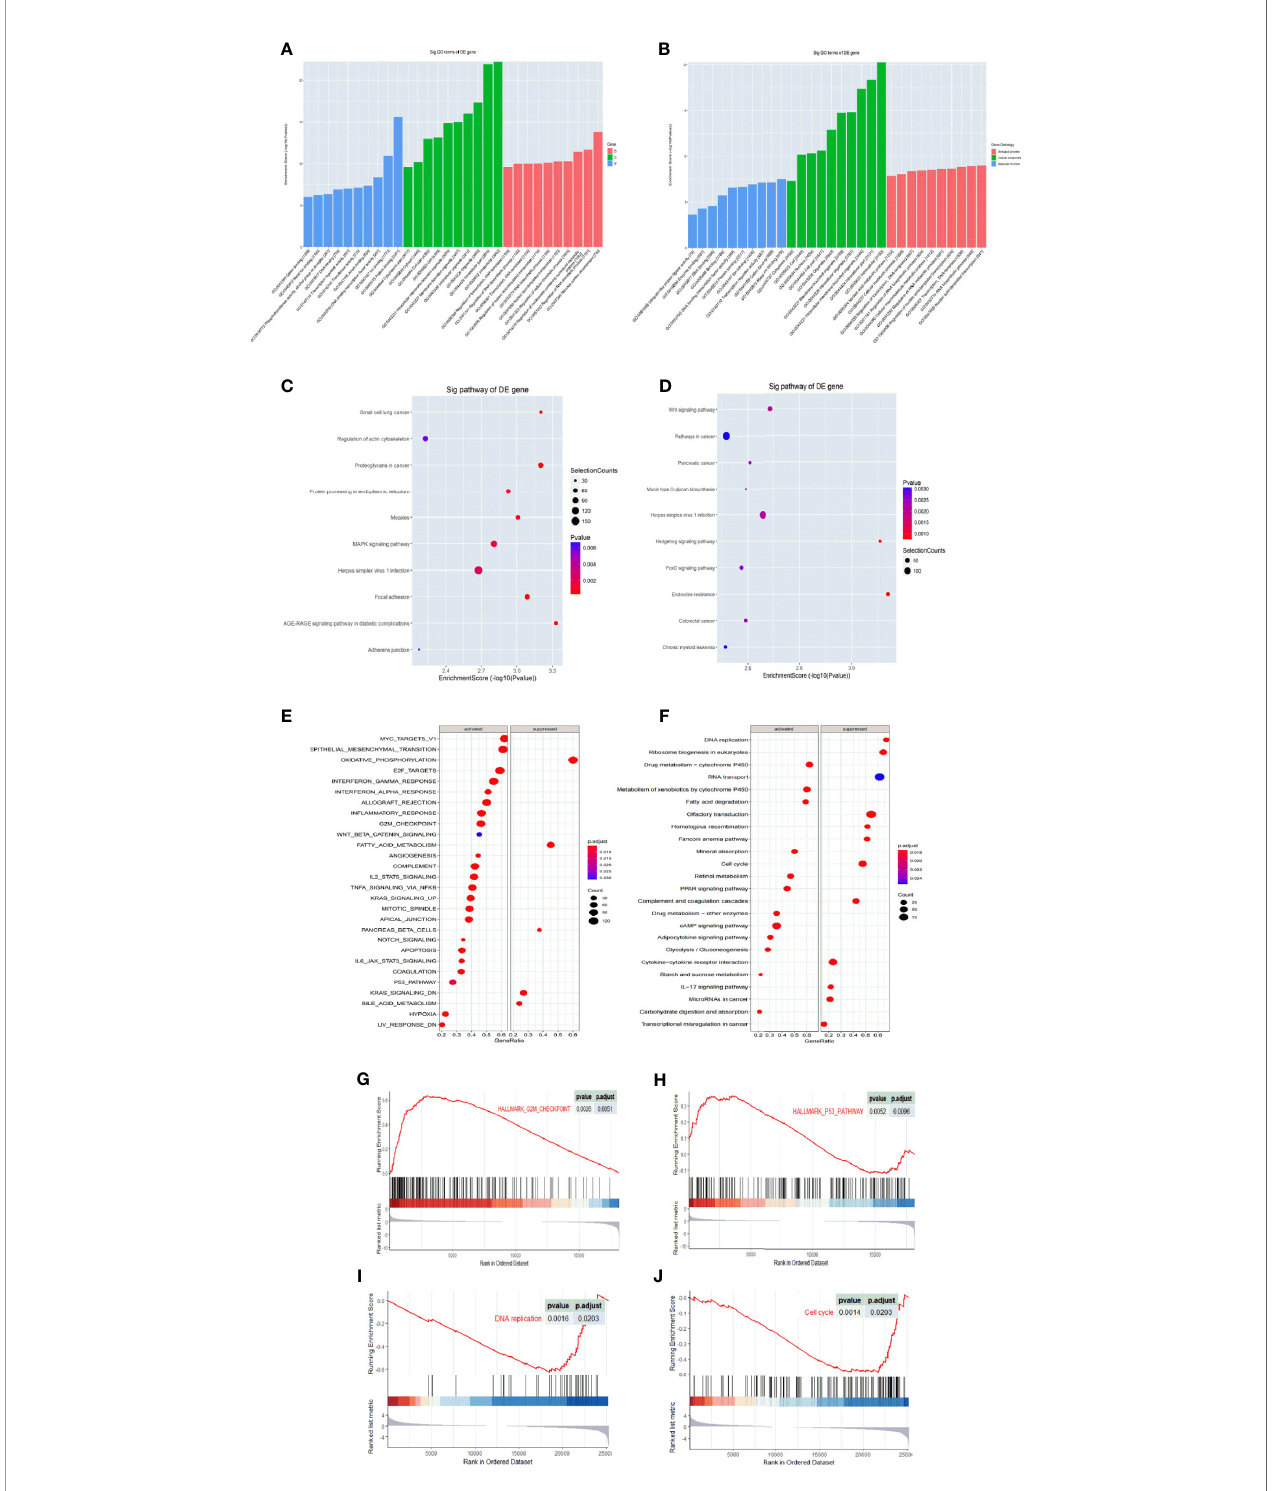
FIGURE 2 | GO and KEGG enrichment analysis of tRF-Glu-TTC-027 target genes. (A) Column chart of up-regulated target genes in GO analysis; (B) Column chart of down-regulated target genes in GO analysis. The enrichment score was denoted on Y-axis, and the MF, CC, and BP terms were showed on X-axis. (C) KEGG pathway analysis showed 10 signi fi cant pathways of up-regulated target genes in gastric cancer tissues. (D) KEGG pathway analysis showed 10 signi fi cant pathways of down-regulated target genes in gastric cancer tissues. (E, F) KEGG pathway analysis of GC in TCGA and GEO databases. (G – J) GSEA analysis of GC in TCGA and GEO databases. DEGs, differentially expressed